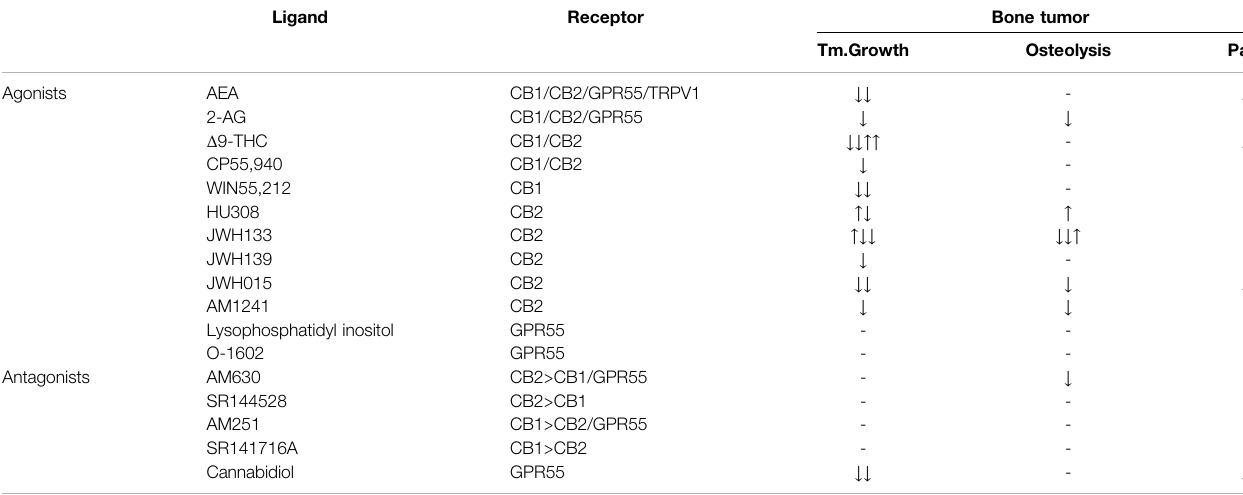
TABLE 2 | The role of cannabinoid receptor ligands in regulating tumor cells and bone diseases in vitro and in vivo . Ligand Receptor